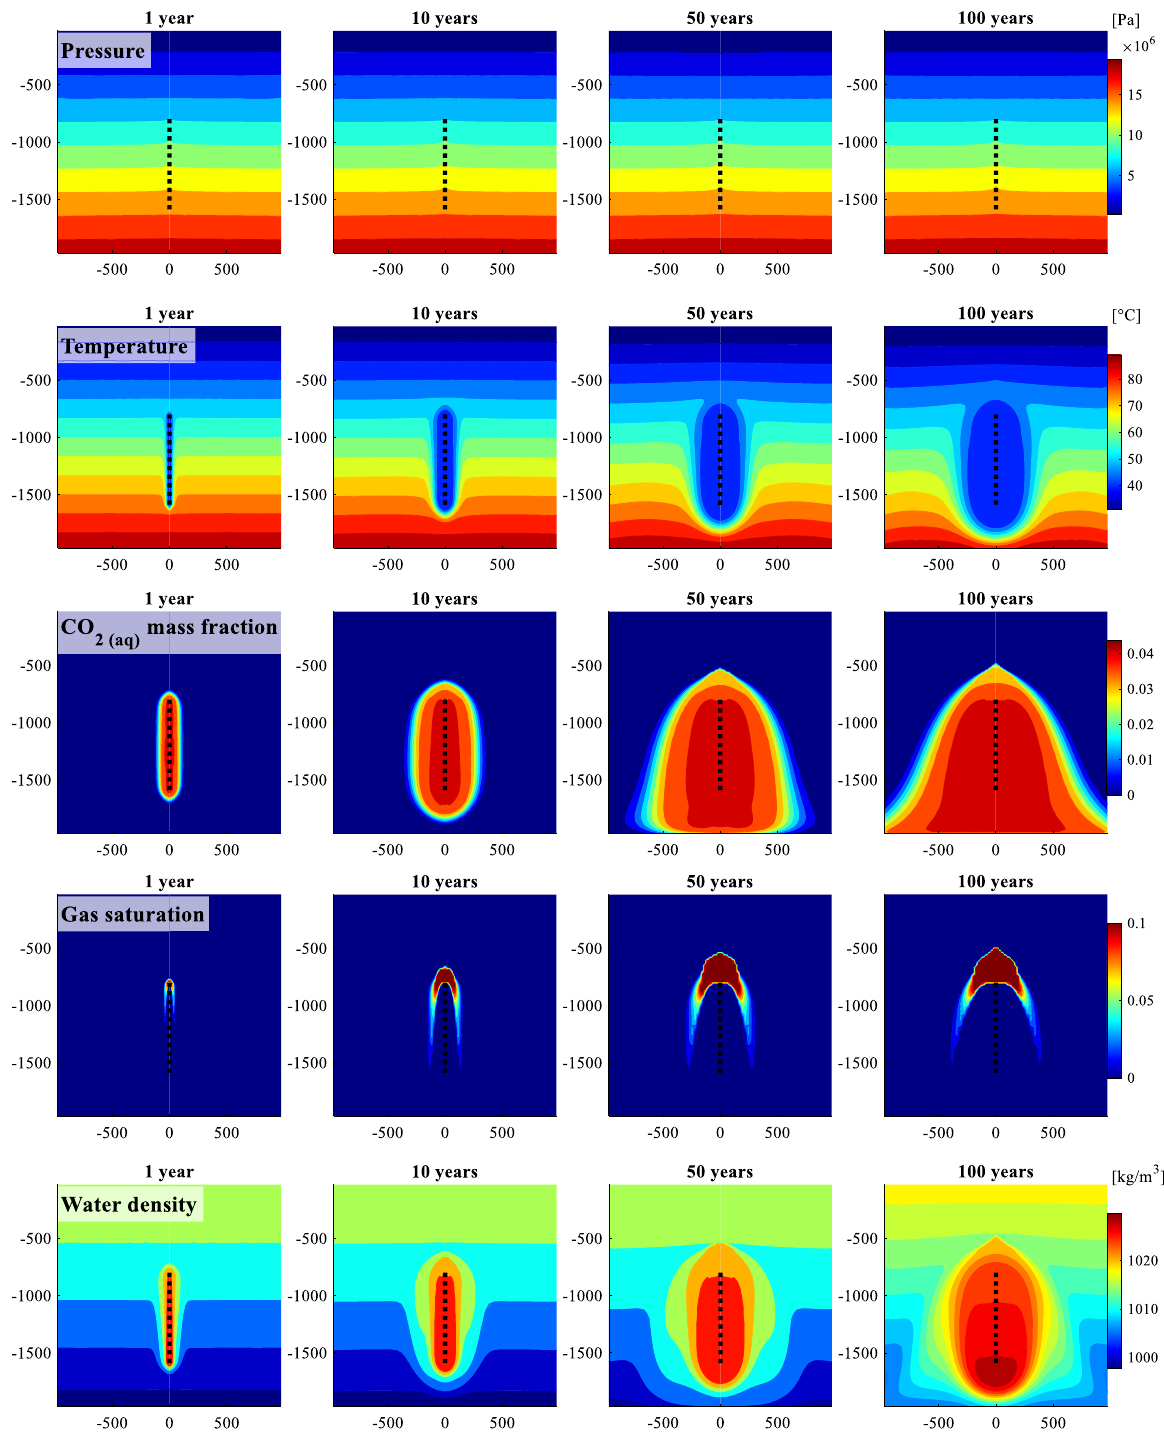
Figure 3. Simulation results for the reference case considered in this study. 2D cross-sections of the (from top to bottom) pressure, temperature, CO 2 mass fraction in the liquid, gas saturation, which is the mass fraction of exsolved CO 2 in the pore fluids, and water density for the reference system after 1, 10, 50 and 100 years of carbonated water injection. Color bars indicating the range for each of the properties are displayed on right side of the plots. The dotted line marks the gas-charged water injection zone. This homogeneous hydrostatically pressured reference system assumes a 30 °C/km gradient, constant salinity of 35000 ppm (seawater), and water injection temperature of 40 °C. The water to CO 2 injection mass ratio is